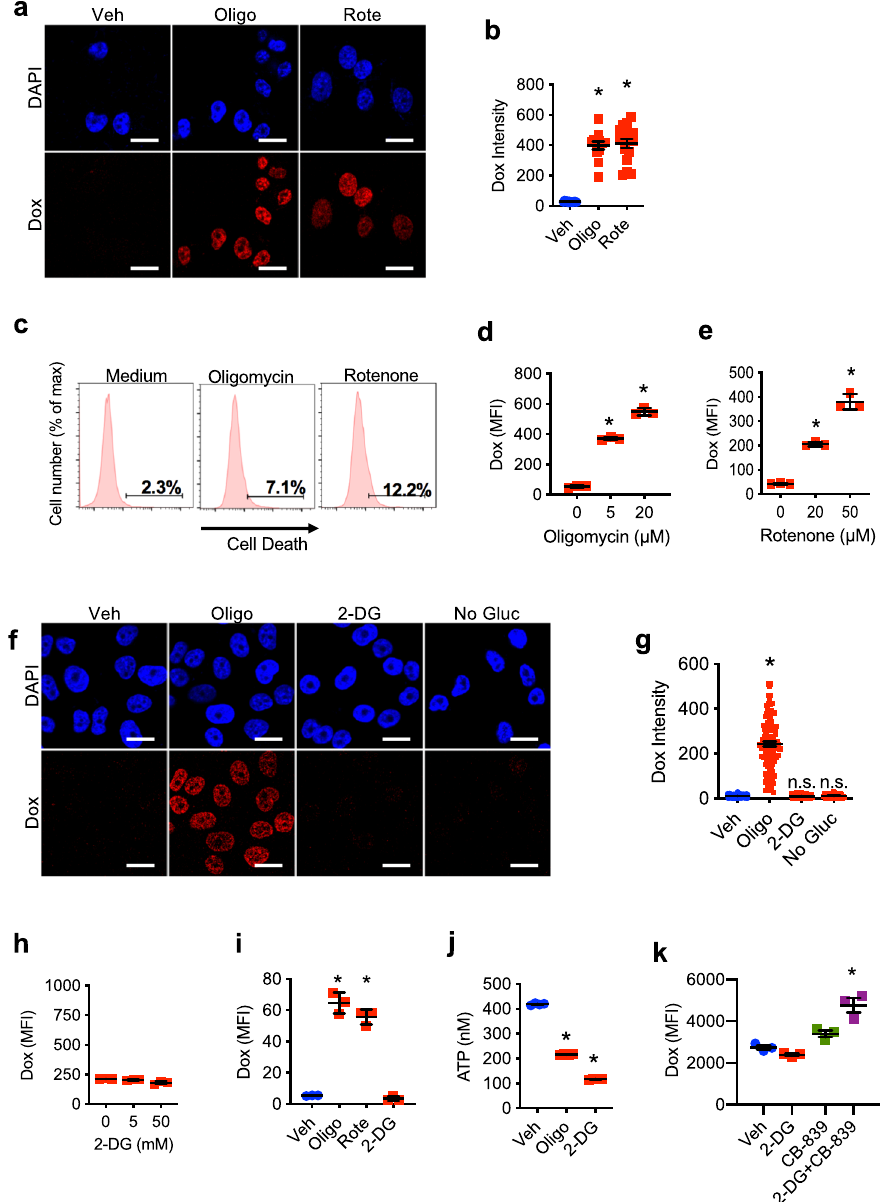
Fig. 2 Mitochondrial respiration, but not glycolysis, is responsible for reduced drug accumulation in chemoresistant cells. a , b NCI/ADR-RES cells were incubated with or without (Veh) oligomycin (Oligo, 5 μ M) or rotenone (Rote, 50 μ M) for 2 h followed by incubation with doxorubicin (Dox, 3 μ M) for 3 h. Cells were then fi xed, stained with DAPI (nuclear dye, blue), and analyzed by confocal microscopy for doxorubicin fl uorescence (red). a Representative images. Scale bars represent 20 μ m. b Quanti fi cation of doxorubicin intensity relative to nuclear area (vehicle n = 12, olligomycin n = 12, rotenone n = 17). p = 0.0001, 0.0001. c Cell death analysis using the Live/Death staining and fl ow cytometry analysis in cells after the treatments described in ( a ). Numbers represent the percentage of dead cells. d , e NCI/ADR-RES cells were incubated with increasing concentrations of d oligomycin ( p = 0.0001, 0.0001) or e rotenone ( p = 0.0006, 0.0001) as indicated for 2 h followed by incubation with doxorubicin (3 μ M) as in ( a ). Cells were then fi xed and analyzed for doxorubicin fl uorescence by fl ow cytometry. Median fl uorescence intensity (MFI) is shown ( n = 3). f , g NCI/ADR-RES cells were incubated with oligomycin (5 μ M) or 2-deoxyglucose (2-DG, 50 mM) for 2 h or without glucose (No Gluc) for 24 h followed by incubation with doxorubicin (3 μ M) as in ( a ). Cells were then fi xed, stained, and analyzed as in ( a , b ). f Representative images. Scale bars represent 20 μ m. g Quanti fi cation of doxorubicin intensity relative to nuclear area (vehicle n = 176, 2-DG n = 75, no glucose n = 46, olligomycin n = 109). p = 0.0001, 0.9918, 0.9999. h NCI/ADR-RES cells were incubated with increasing concentrations of 2-deoxyglucose as indicated for 2 h followed by incubation with doxorubicin as (3 μ M) in ( a ). Cells were then fi xed and analyzed as in ( e , f ) ( n = 3). p = 0.3372, 0.0012. i MES/Dox cells were incubated with oligomycin (5 μ M), rotenone (50 μ M), or 2-deoxyglucose (50 mM) for 2 h followed by incubation with doxorubicin as in ( a ). Cells were then fi xed and analyzed as in ( d , e ) ( n = 3). p = 0.0001, 0.0001, 0.967. j NCI/ADR-RES cells were incubated with oligomycin (5 μ M) or 2-deoxyglucose (50 mM) for 5 h and then total ATP levels were determined by Luciferase assay ( n = 4). ATP concentration (10 4 cells) is shown. p = 0.0001, 0.0001. k NCI/ADR-RES cells were incubated with 2-DG (50 mM), CB-839 (5 μ M) or both for 2 h followed by incubation with doxorubicin (3 μ M), and analyzed for doxorubicin fl uorescence by fl ow cytometry. p = 0.479, 0.1162, 0.0003. Mean± SEM is provided for all fi gures. * denotes p < 0.05 by one-way ANOVA and Tukey ’ s multiple comparisons test. Results are representative of at least two experiments.